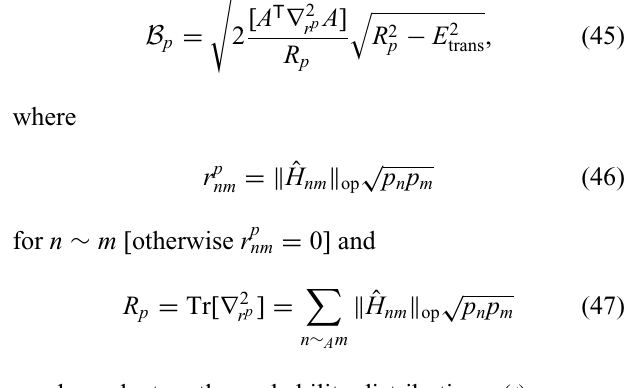
(cid:8) | J q | , E nm trans , and n ∼ A m